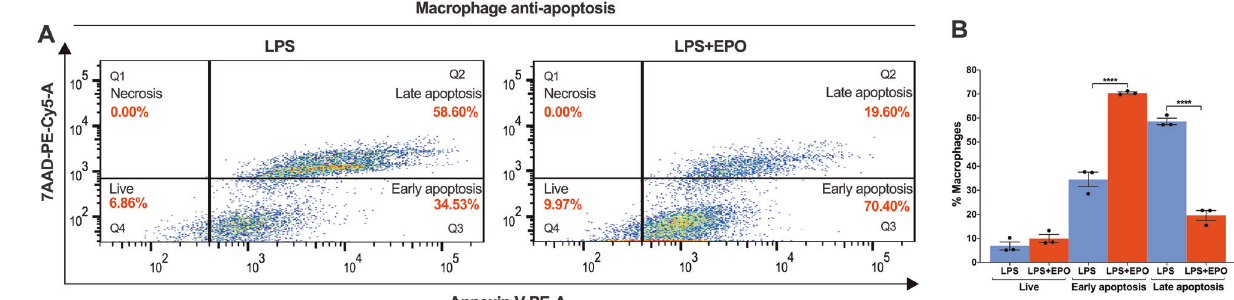
Fig. 6 EPO treatment augments M2 phenotype macrophage anti-apoptosis function following LPS treatment. A Flow cytometry data shows that LPS + EPO treatment signi fi cantly attenuates % late apoptosis (Q2 quadrant) and as a result, it increases the percentage of early apoptosis (Q3 quadrant) and the live cells (Q4 quadrant) as compared to LPS treatment. None of the treatments shows positive for necrosis. BMMØs treated with LPS (50 ng/mL) for 24 h and EPO (5 IU/mL) for 72 h. B The results of apoptosis are mentioned in the bar graph. One-way